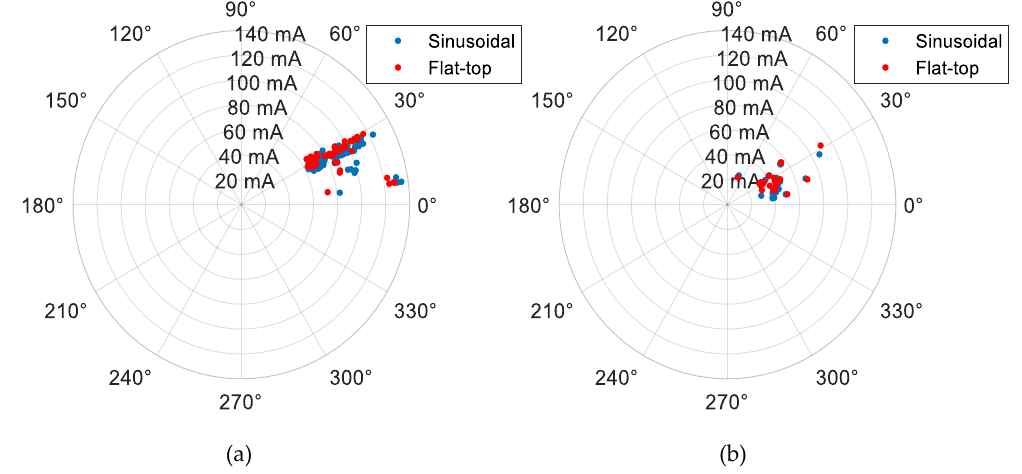
Figure A1. Fundamental current emission of the selected lamps under the two types of supply voltage: ( a ) CFL and ( b ) LED lamps.